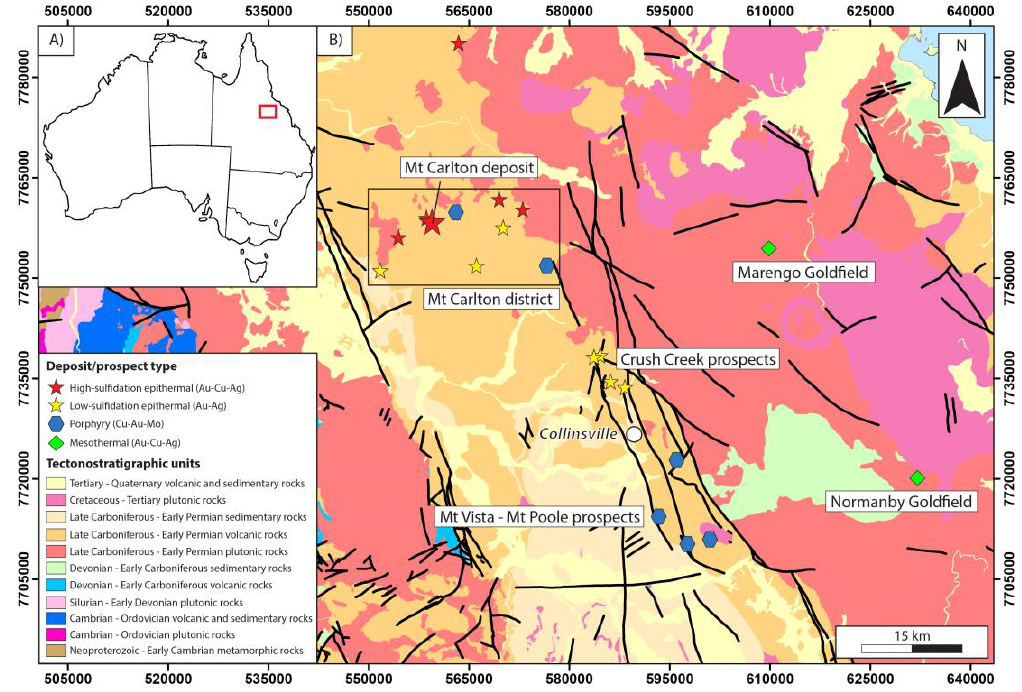
Figure 1. ( A ) Location of the northern Bowen Basin (red rectangle) in NE Queensland, Australia. ( B ) Geologic map of the northern Bowen Basin (center of map) and the corresponding Connors Arc (right-hand side of map), showing the location of the known porphyry, epithermal and mesothermal mineral occurrences. Grid—UTM zone 55; datum—GDA94. From Sahlström et al. [30].